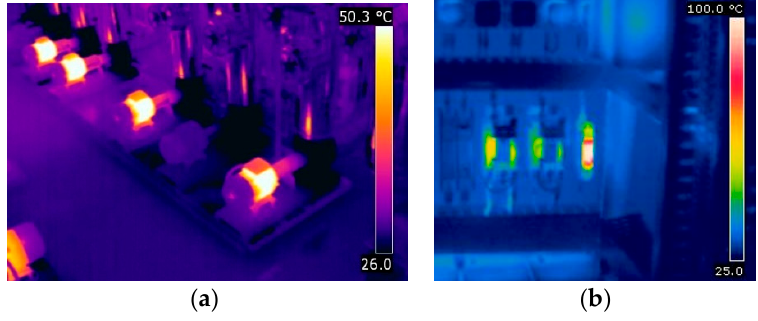
Figure 18. Thermal images from industrial application. ( a ) Fault in a motor; ( b ) fault in a contactor.